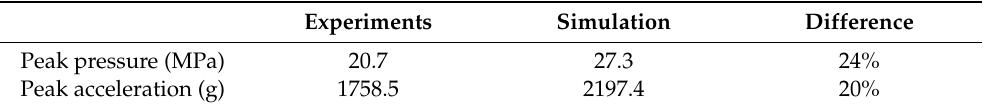
Table 8. Comparison of the peak pressure and acceleration values of experiments and simulation.